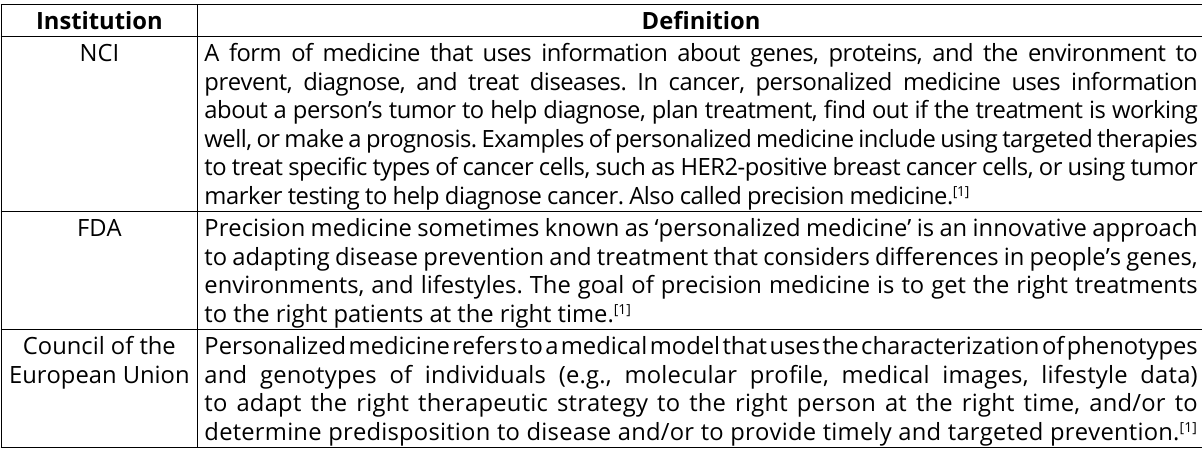
Table 1. Definitions of personalized medicine from the main institutions mentioned by Jørgensen (2019). [1] Institution